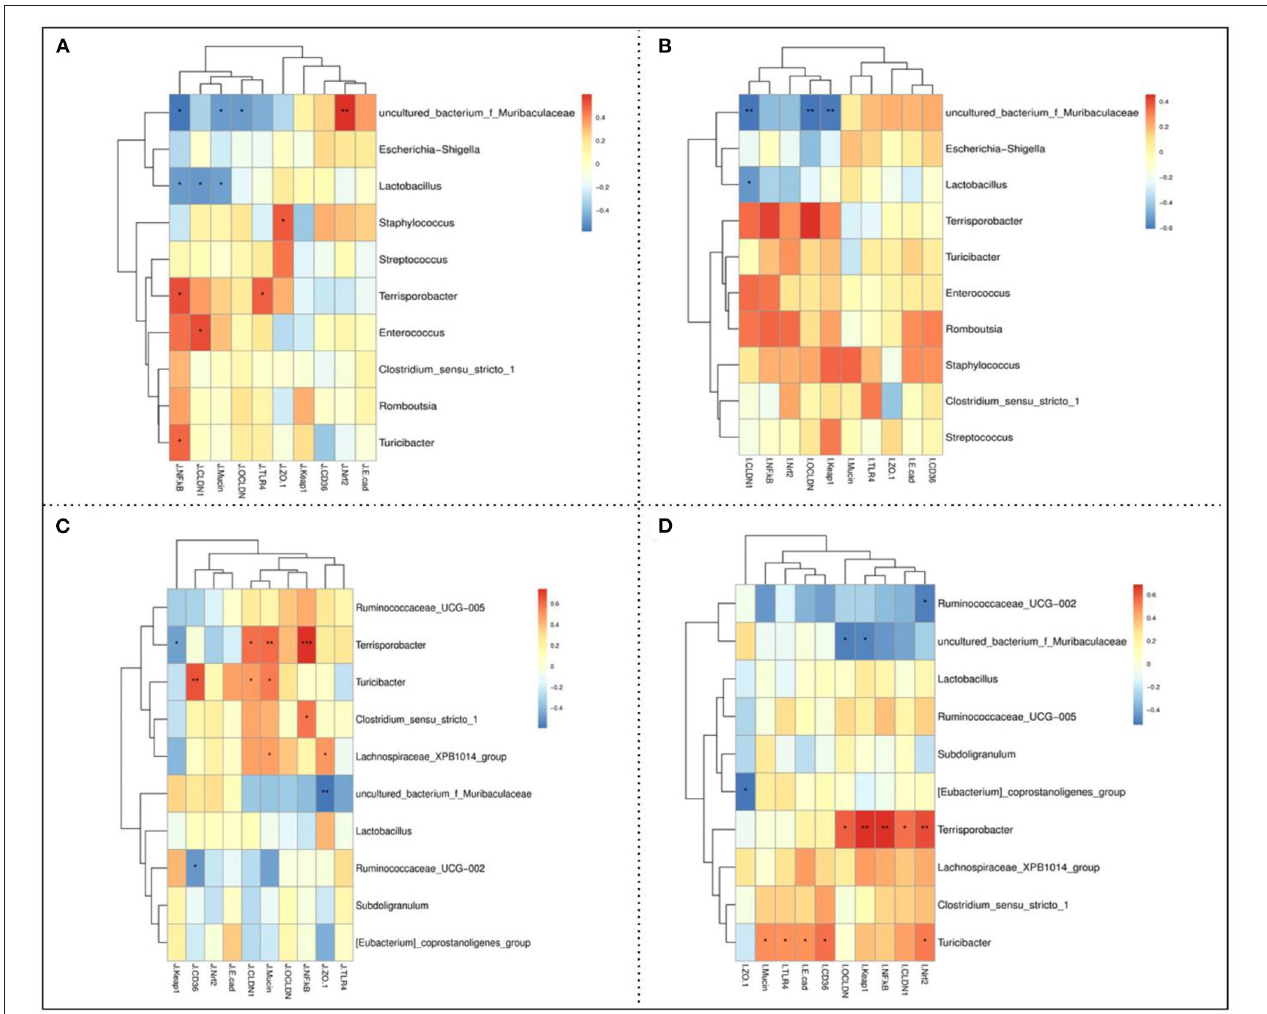
FIGURE 5 | Spearman’s correlation between the jejunal (A) and ileal (B) barrier function-related parameters and ileal microbiota abundances, and jejunal (C) and ileal (D) barrier function-related parameters and colonic microbiota abundances. * P < 0.05, ** P < 0.01, and *** P <